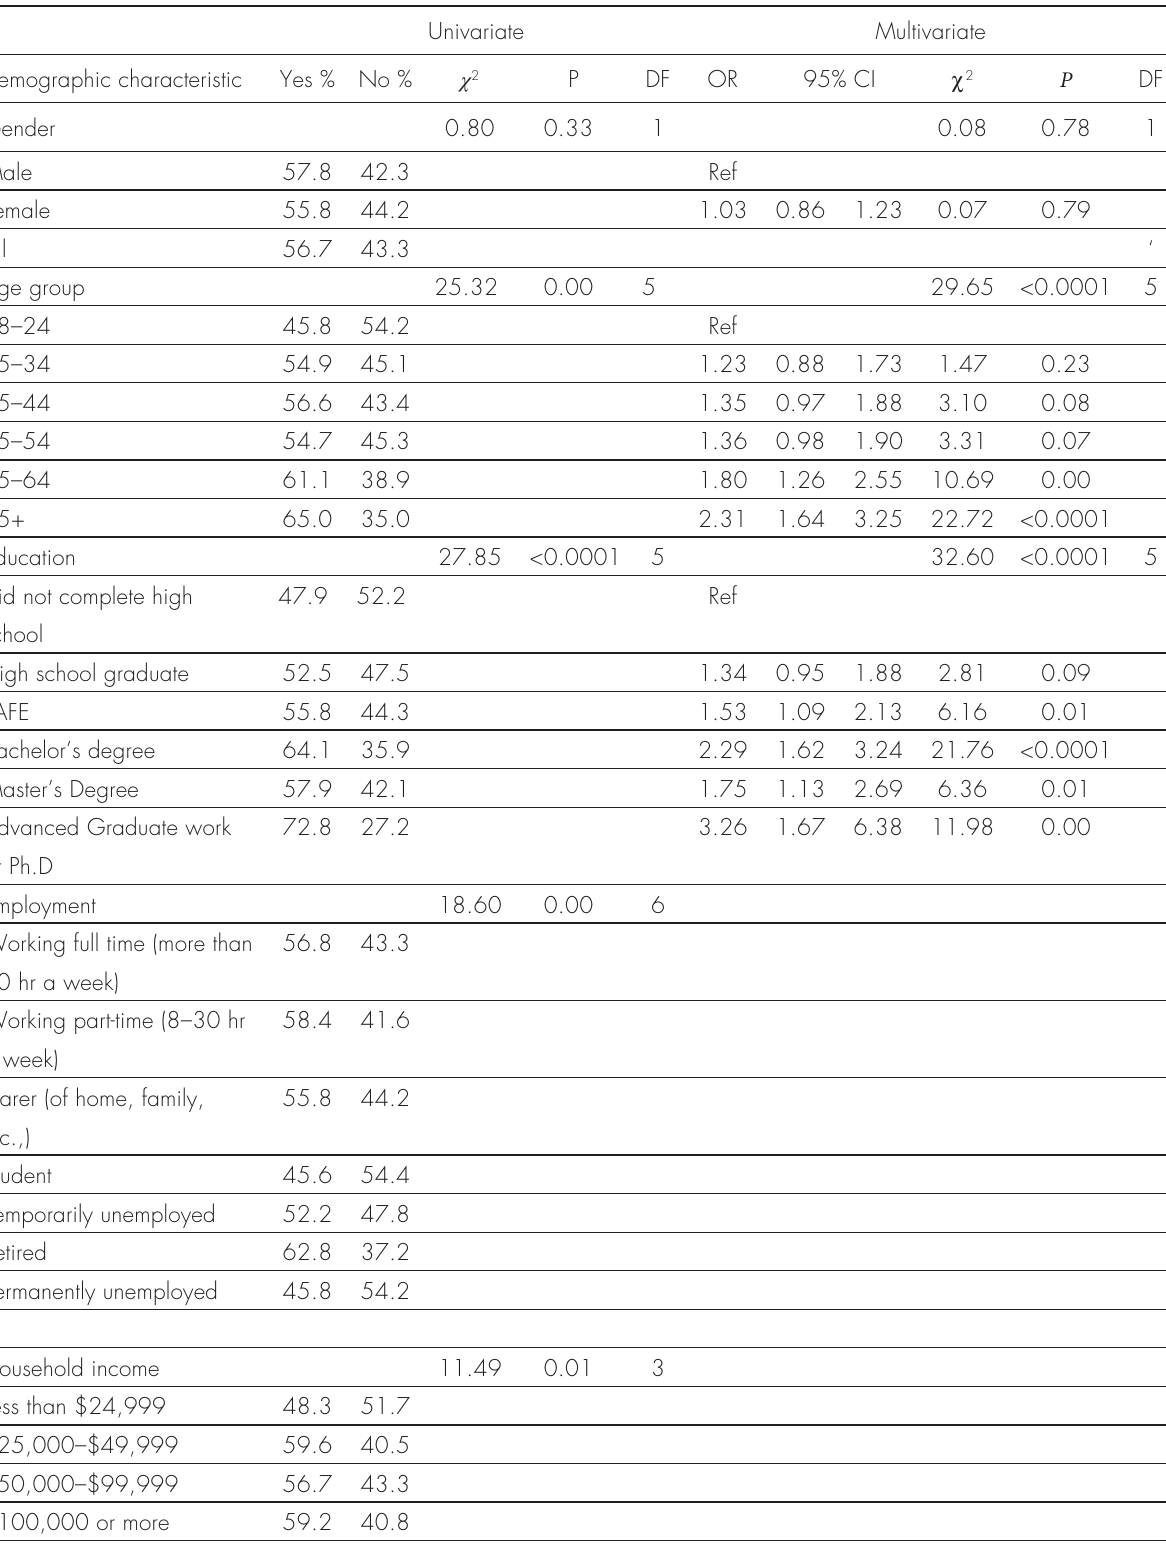
Table II. Demographic characteristics (gender, age group, education, employment status, annual income) and their associations with awareness of obstructive sleep apnoea.